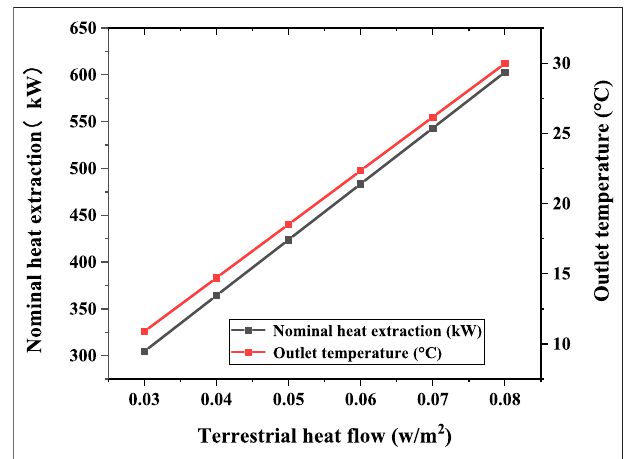
FIGURE 4 | Nominal heat extraction and the outlet temperature at different fl ow rates.